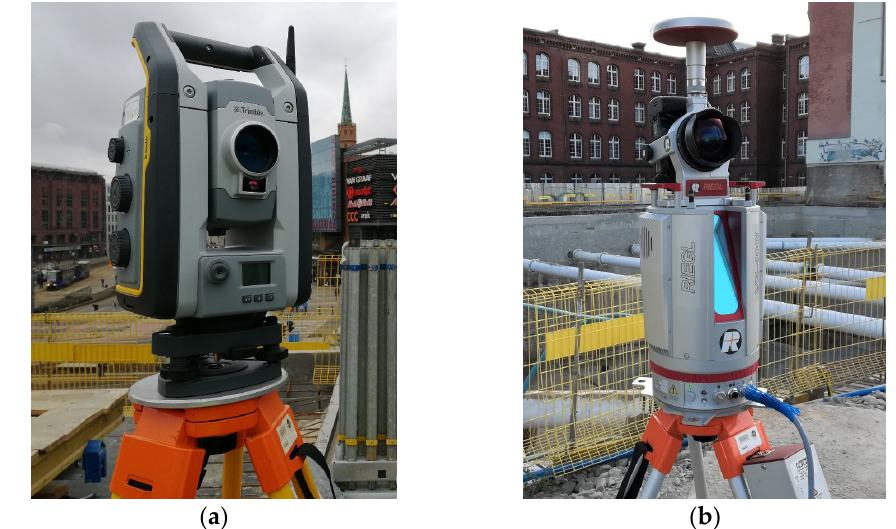
Figure A1. Geodetic instruments used in the course of the measurements: ( a ) Trimble S7 robotic total station; ( b ) Riegl VZ-400i laser scanner.